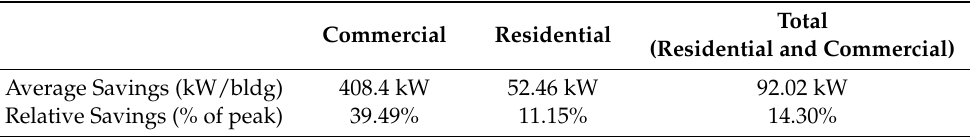
Table 4. Average demand savings, both absolute (kW) and relative (% peak), for 178,337 buildings from a utility-controlled smart thermostat under a 2.2 ◦ C pre-conditioning scenario.